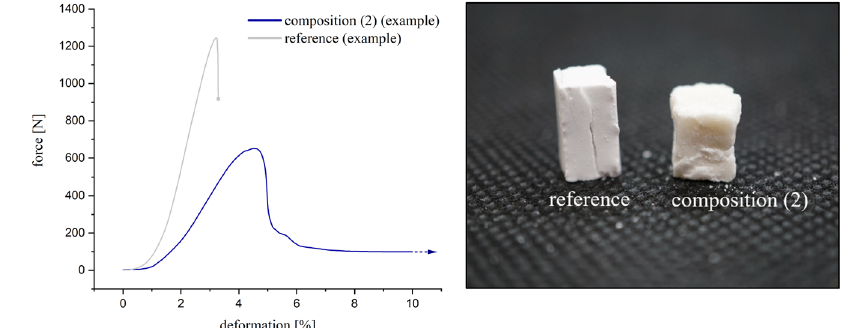
Fig. 3 Examples of characteristic modes of failure in comparison. Blue curve/right cubus: Ductile material failure of composition (2) with plastic deformation. Grey curve/left cubus: Brittle fracture of the reference OPLS/TTCP with abrupt material failure without plastic